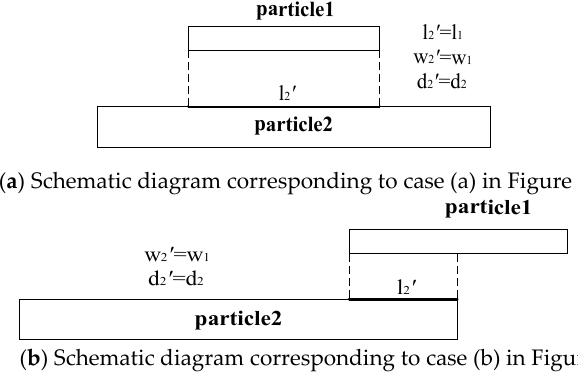
Figure 8. Schematic diagram of the projection step as plate1 is treated as the wall. Minerals 2020 , 10 , x FOR PEER REVIEW